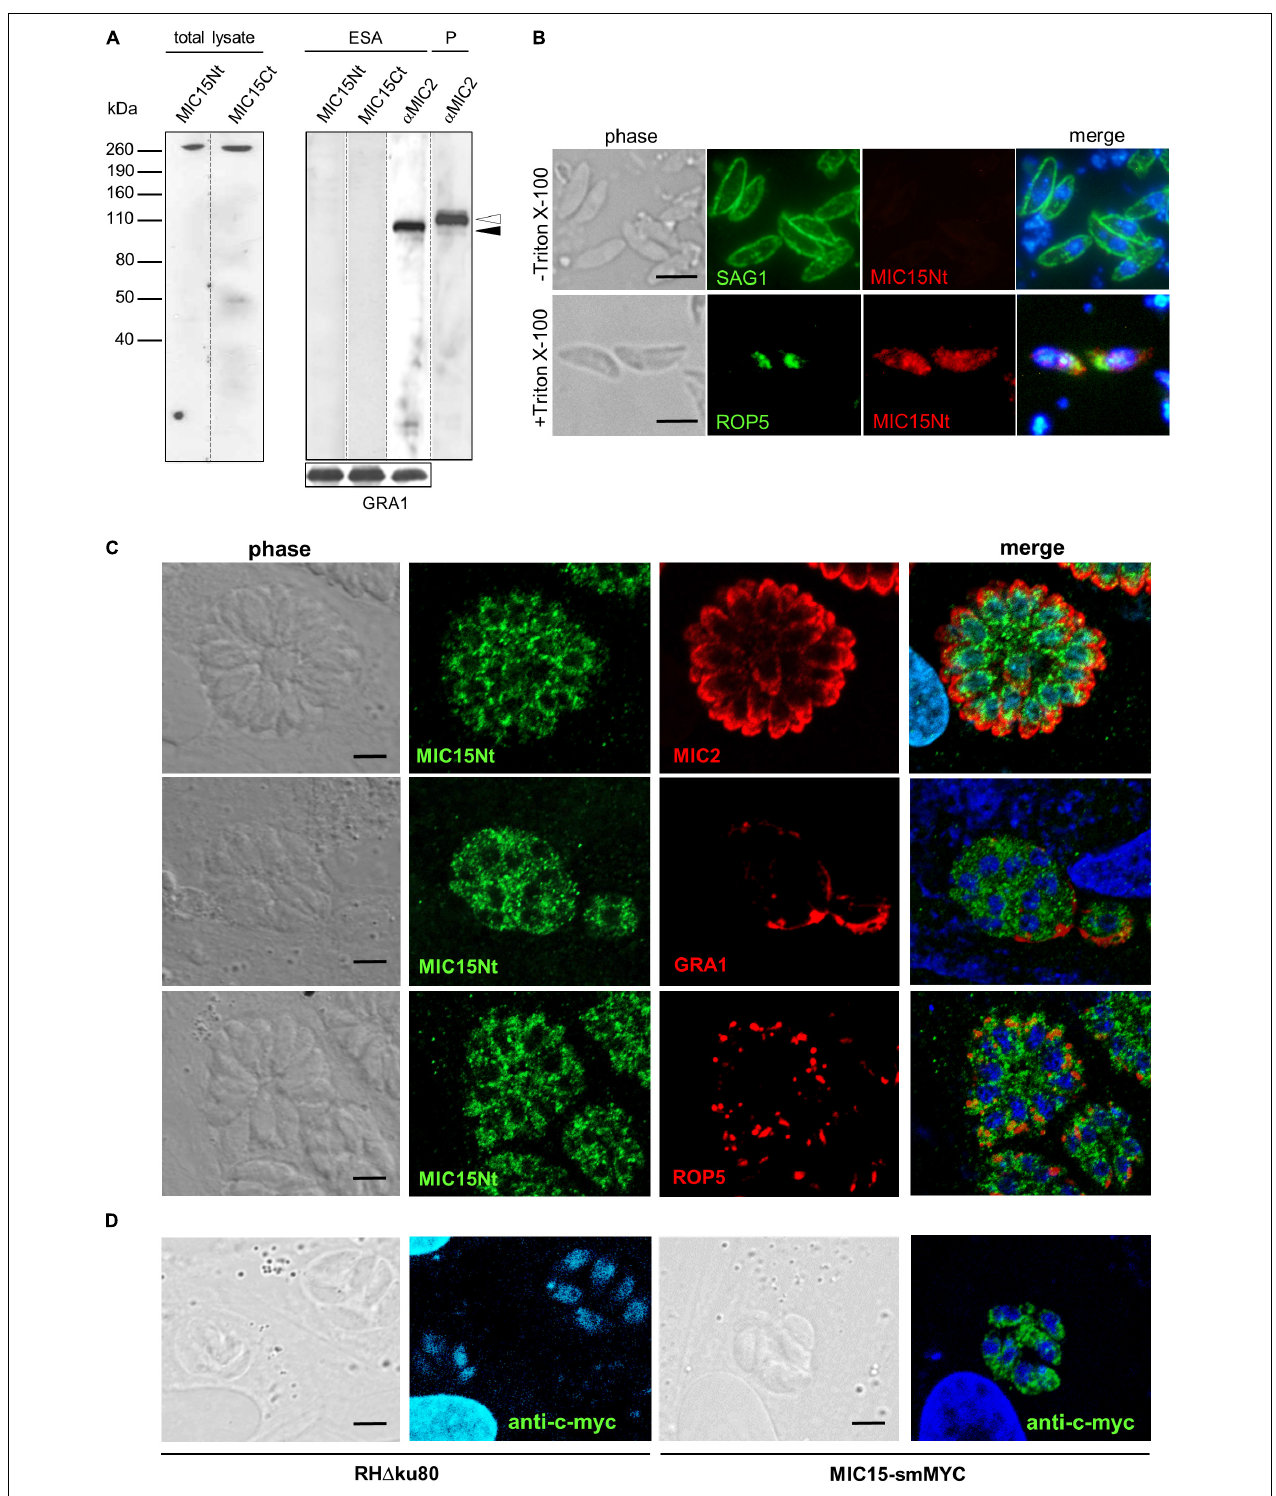
FIGURE 3 | MIC15 is expressed in T. gondii tachyzoites and shows a dispersed intracellular localization. (A) Western blot analysis of proteins contained in the total tachyzoite lysate (left panel) or in the excreted-secreted antigens (ESA) fraction and in the corresponding parasite pellet (P) (right panel). MIC15 was detected with the rabbit antibodies MIC15Nt or MIC15Ct ( Figure 2B ). The anti-MIC2 mAb T34A11 (Achbarou et al., 1991) was used as positive control of the ESA fraction and its associated pellet. The intracellular and the cleaved extracellular forms of MIC2 are indicated by white and black arrowheads, respectively. T. gondii GRA1 was